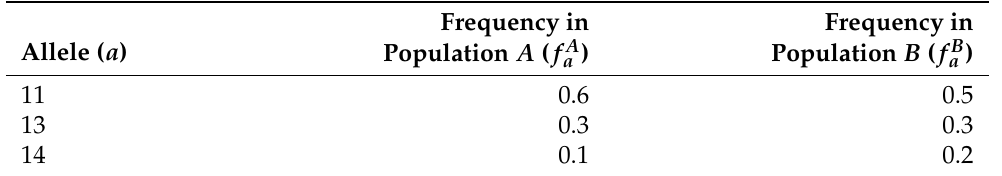
Table 2. Allele frequencies used in likelihood ratio calculation for the electropherogram shown in Figure